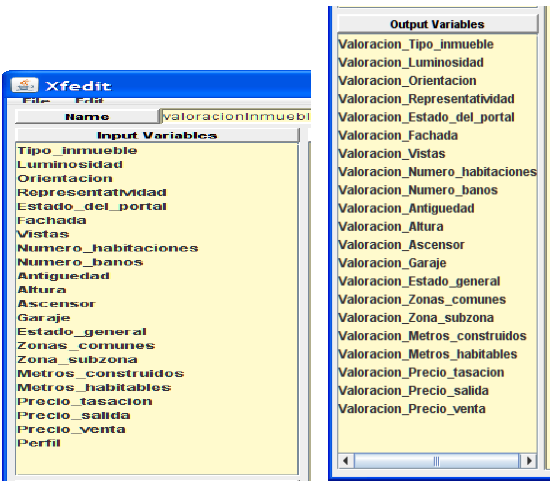
Fig. 5: Input (left) and output (right) variables in Xfuzzy